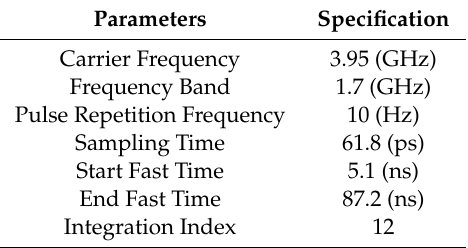
Table 4. Operative Radar System Parameters: Second